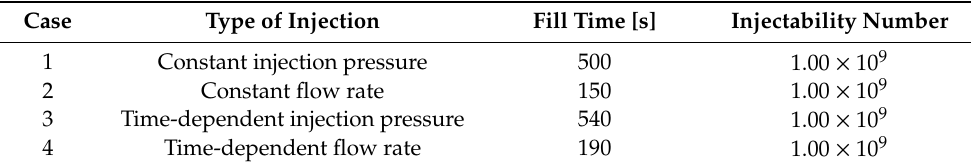
Table 2. Numerically calculated fill times and injectability numbers for unidirectional injections in a rectangular cavity (the results are rounded to the third significant digit).